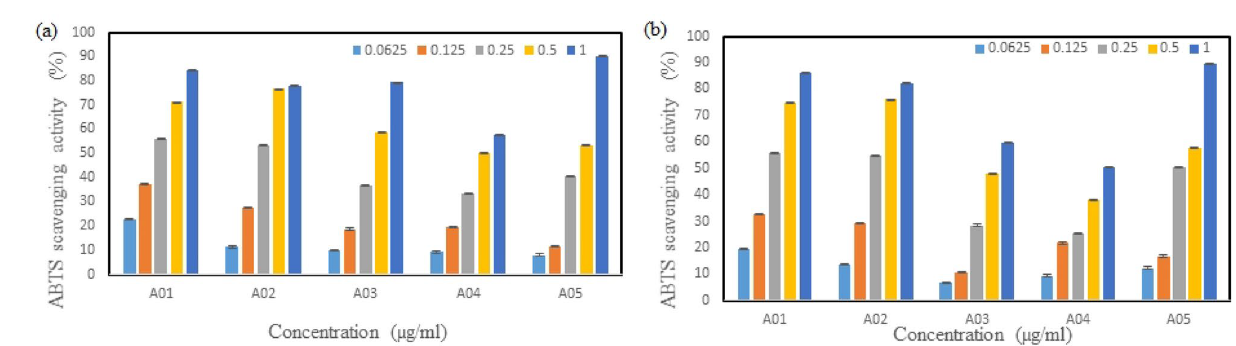
Figure 3. ABTS radical scavenging activity of fucoidan obtained from S. ilicifolium at different locations that was extracted at ( a ) 65 °C and ( b ) 80 °C. Bars indicate SD, n = 3.